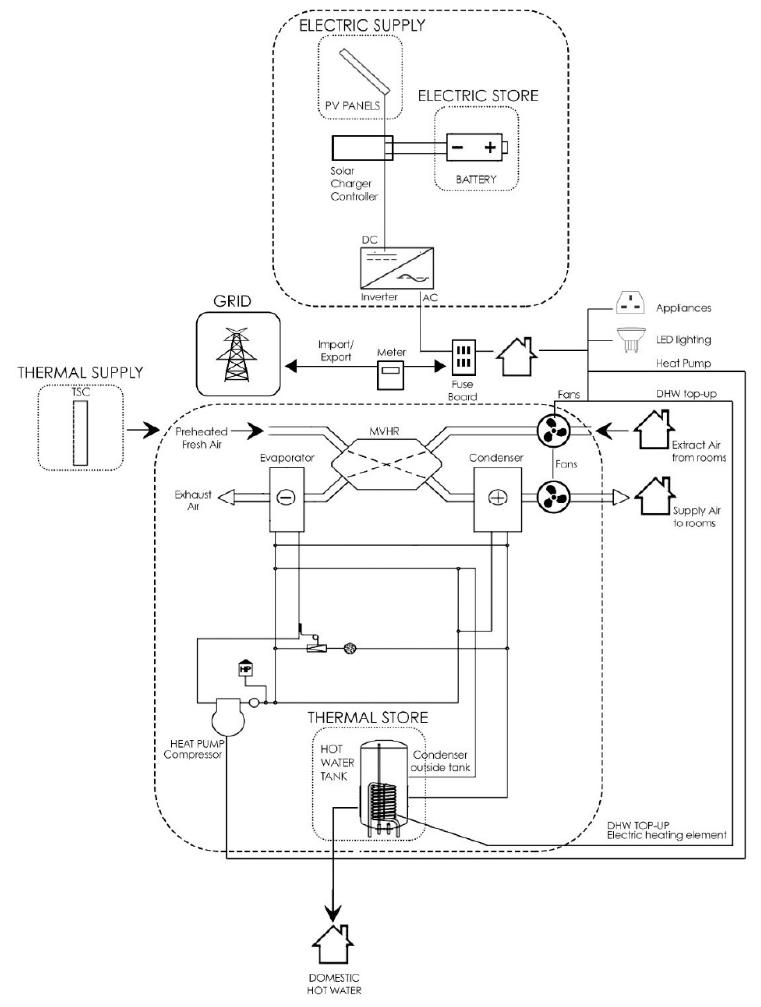
Figure 3. SOLCER house schematic of electrical and thermal system.